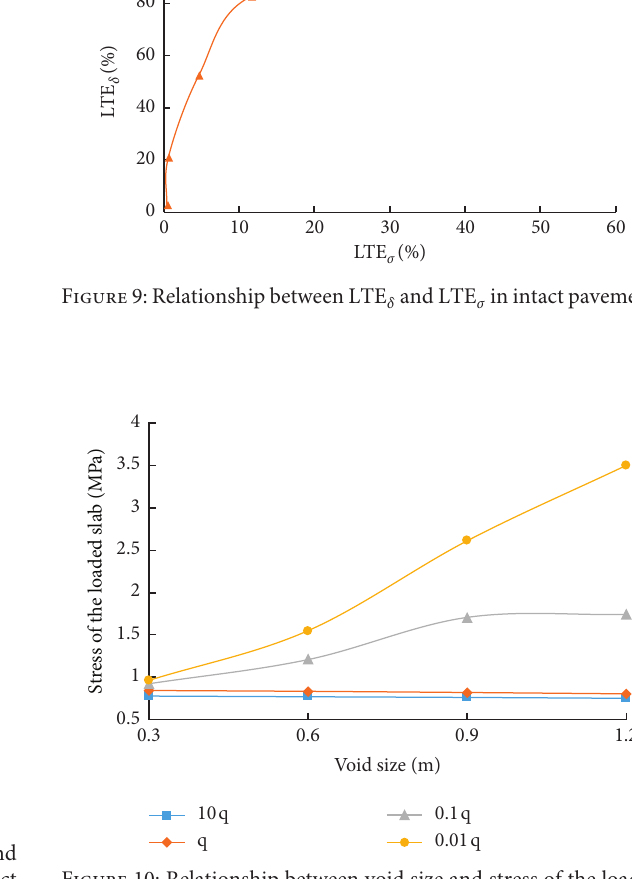
Figure 10: Relationship between void size and stress of the loaded slab in pavement with void underneath loaded